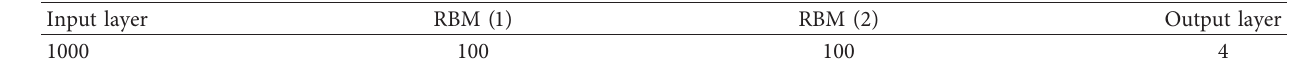
Figure 10: The variation of RMSE with the number of iterations. Table 5: The structural parameters of DBN.